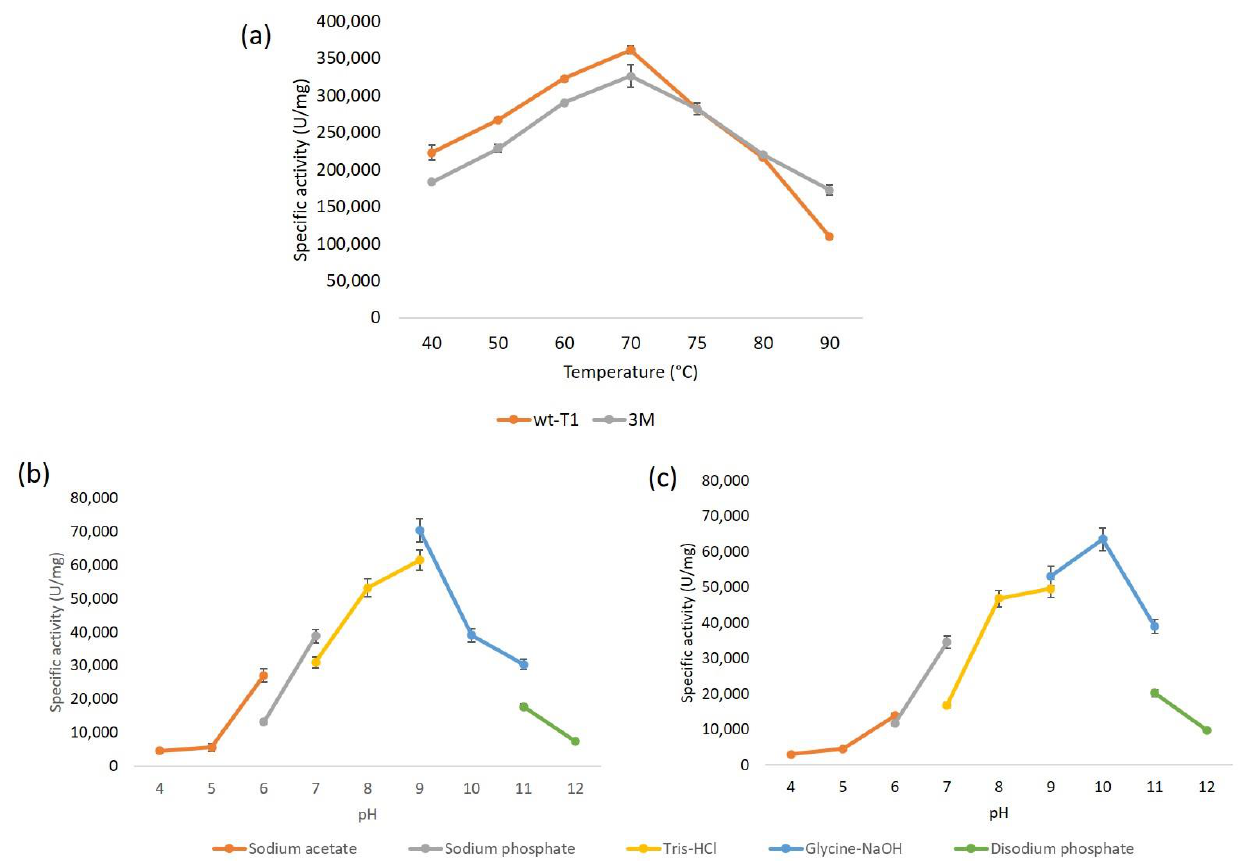
Figure 2. Biochemical characterization of lipases. ( a ) The temperature profile of wt-T1 and 3M li- ( b , c ) pH profile on the activity of wt-T1 and 3M lipases, pases. ( b , c ) pH profile on the activity of wt-T1 and 3M lipases, respectively.